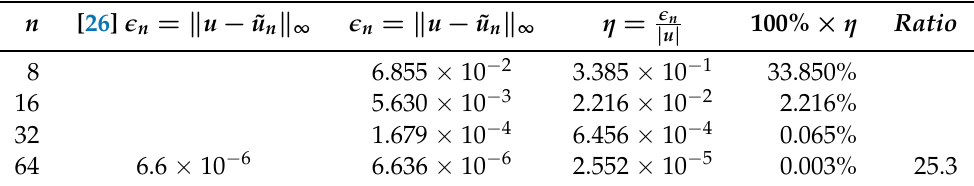
Table 11. IE (50), λ A = − 0.5, c = 0.1. QM: Simpson’s